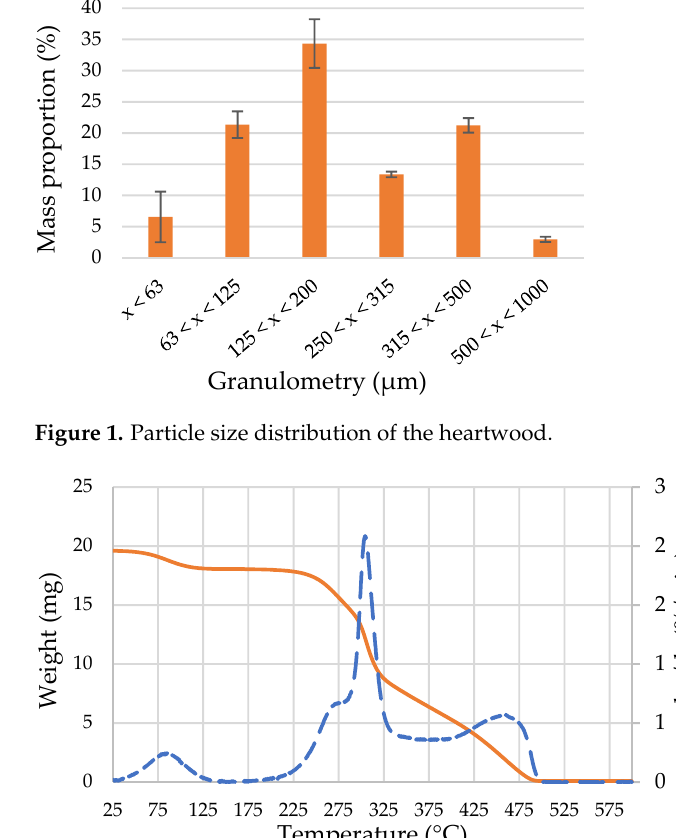
Figure 1. Particle size distribution of the heartwood.